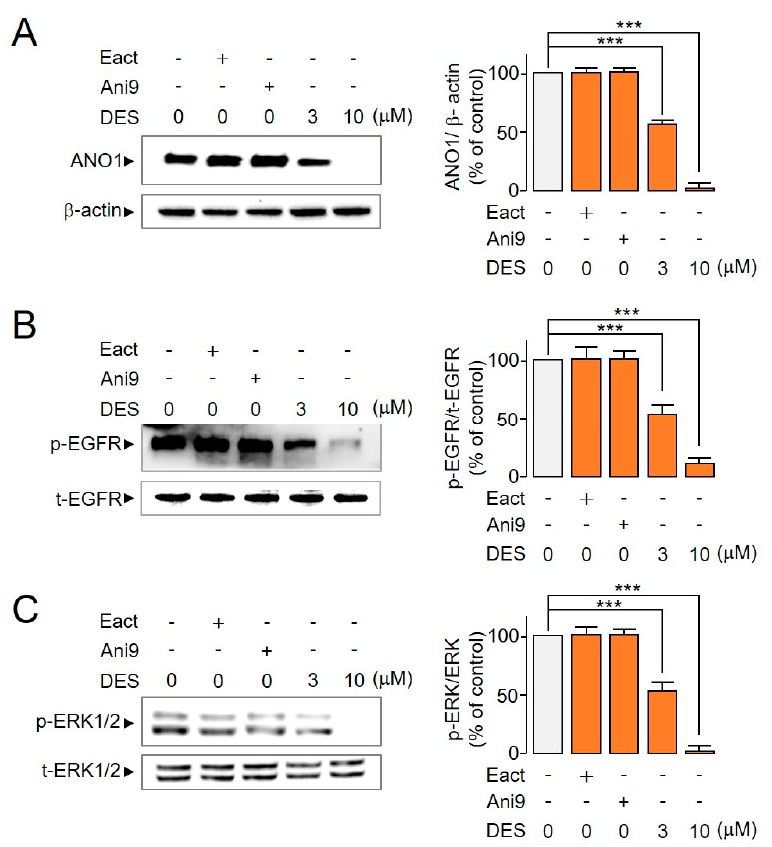
Figure 6. Effect of ANO1 activator (Eact) and inhibitors (Ani9, DES) on ANO1, p -EGFR and p -ERK1/2 protein levels. ( A ) Immunoblot-mediated detection of ANO1 in PC9 cells expressing high levels of ANO1. The cells were subjected to treatment with the indicated concentrations of Eact, Ani9, or DES for 72 h. (right) ANO1 protein intensities were normalized to those of β -actin (mean ± S.D., n = 5). ( B ) The levels of phosphorylation of EGFR in the presence of ANO1 modulators. (right) The p -EGFR band intensities were normalized to those of t-EGFR (mean ± S.D., n = 5). ( C ) The levels of phosphorylation of ERK1/2 in the presence of ANO1 modulators. (right) The p -ERK1/2 levels were normalized to those of t-ERK1/2 (mean ± S.D., n = 5). *** p < 0.001.